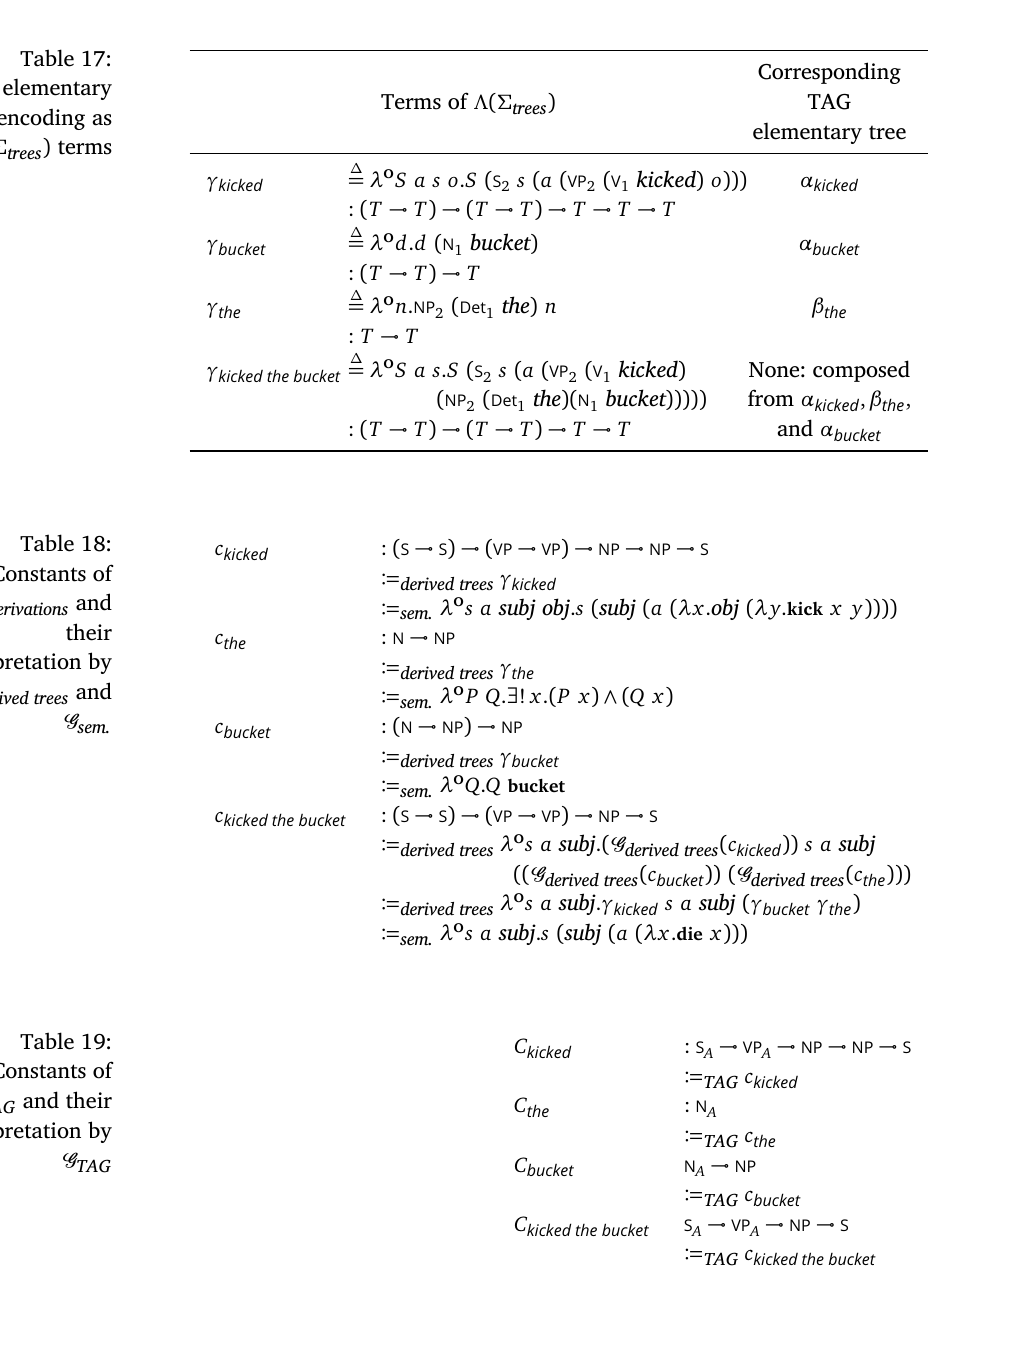
Corresponding elementary tree